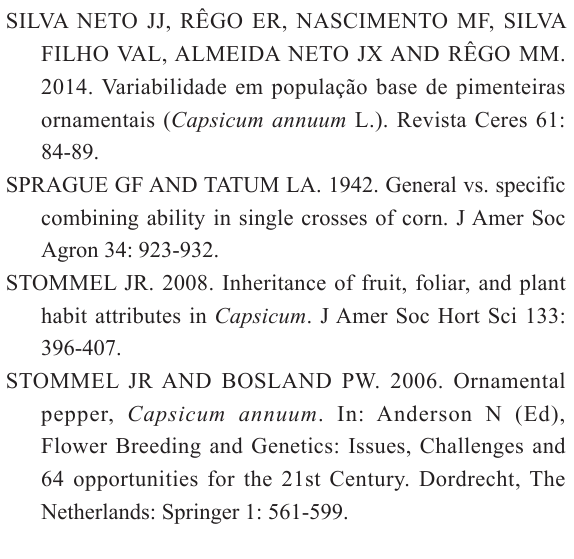
Table SII - Seedling and plant quantitative traits for seven accessions and 42 hybrids of Capsicum annuum L. Values are